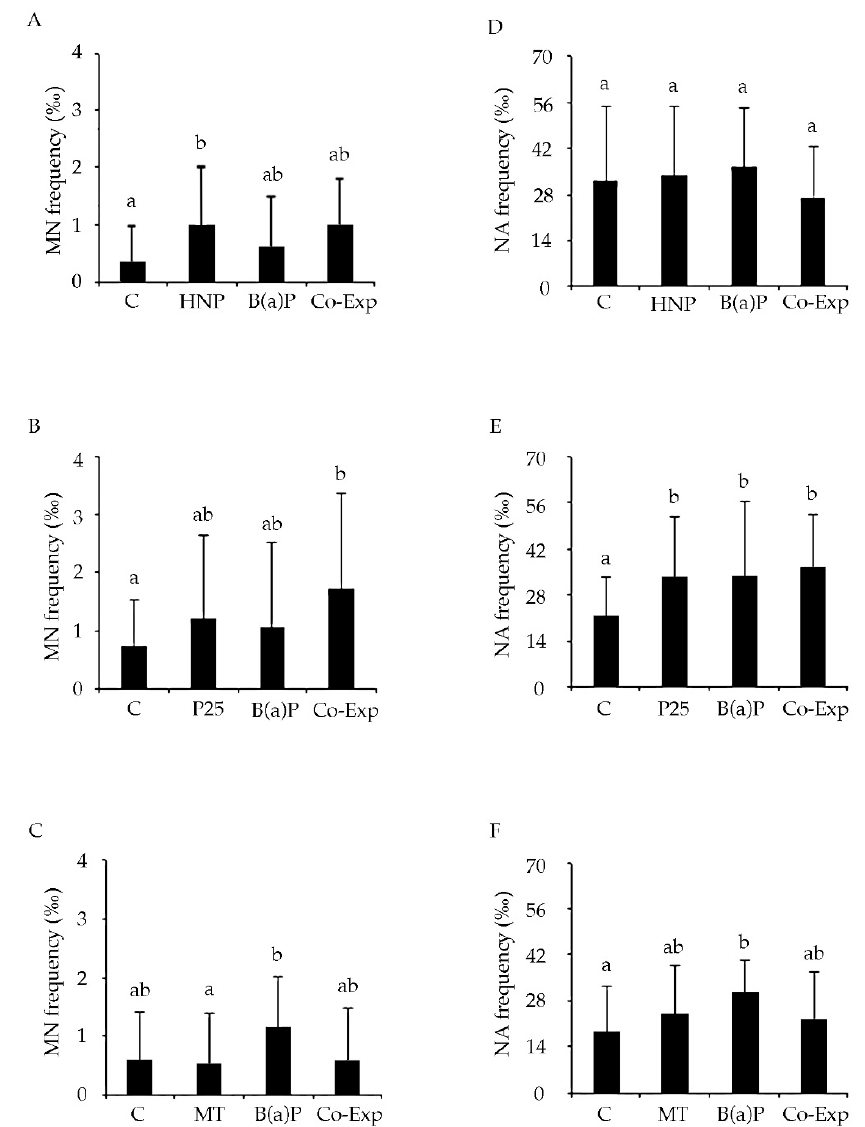
Figure 4. Chromosomal damage (MN and NA frequency) evaluated in gill cells of M. galloprovin- cialis after exposure to the following experimental groups: C = control (ASW); HNP = 10 µ g/mL Hydrophilic CB-derived nanoparticles; P25 = 50 µ g/mL Aeroxide ® TiO 2 P25; MT = 50 µ g/mL Meso- porus; B(a)P = 2 µ g/mL Benzo(a)Pyrene; and NPs, in co-exposure with B(a)P. ( A,D ) Co-exp: B(a)P and HNP. ( B,E ) Co-exp: B(a)P and P25. ( C,F ) Co-exp: B(a)P and MT. Values are mean ± SD. Different letters indicate significant difference between the groups (Multiple Range Test, MRT p < 0.05, n = 9 for each experimental